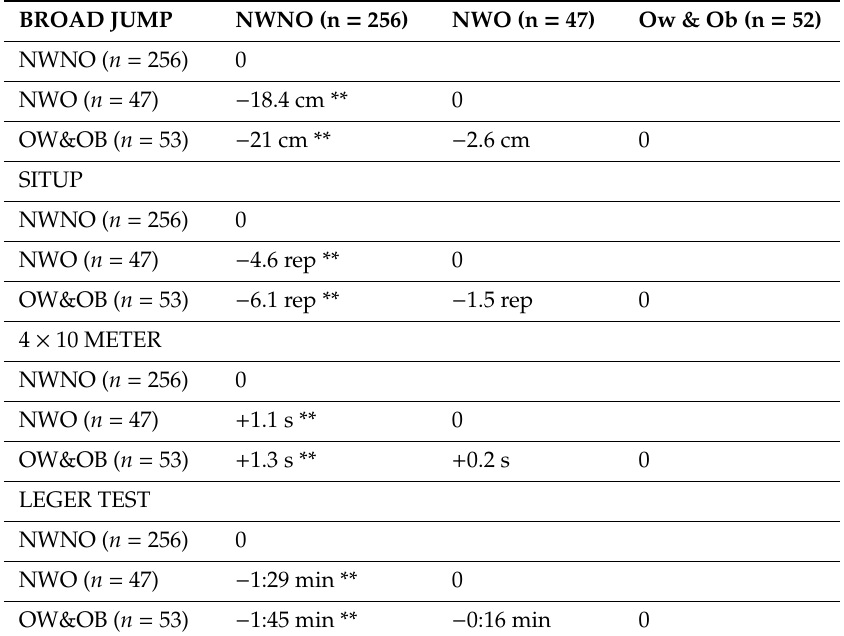
Table A1. Post hoc analysis and certain di ff erences in physical fitness tests between the three groups of children. BROAD JUMP NWNO (n = 256) NWO (n = 47) Ow & Ob (n =